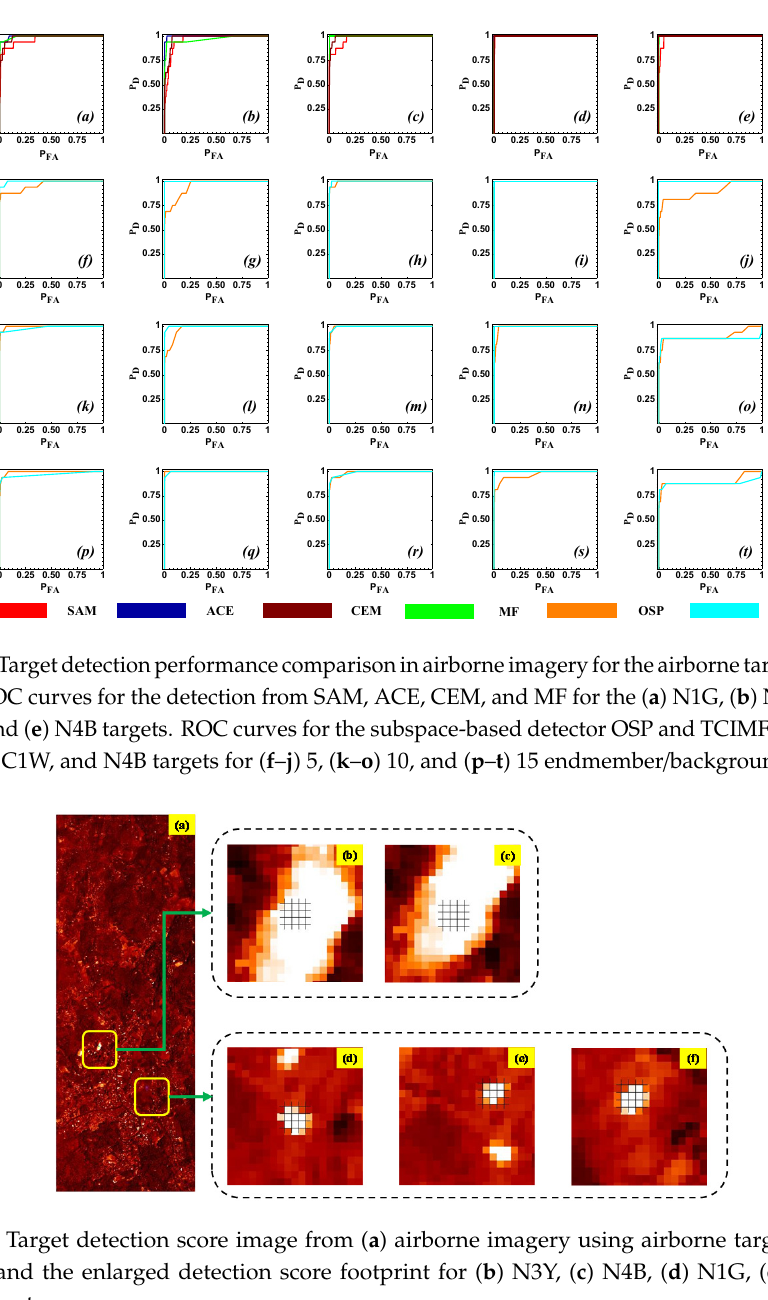
17 of 30 Figure 12. Target detection score image from ( a ) space-borne imagery using THI target reference spectra and the enlarged detection score footprint for ( b ) N3Y, ( c ) N4B, ( d ) N1G, and ( e ) N2R target. 3.3. Target Reference Spectra from the Airborne Hyperspectral Imagery 3.3.1. Target Detection in Airborne Hyperspectral Imagery Target detection experiments were carried out on the airborne hyperspectral imagery and space- borne multispectral imagery using considering pixel-based spectra extracted from the airborne hyperspectral imagery as target reference spectra. Figure 13 shows the target detection scores for the different types of targets in the airborne hyperspectral imagery. Targets were detected with detection scores exceeding 90% with negligible false alarm rates. The accurate detection of the lowest false alarm rates across the target types and detection